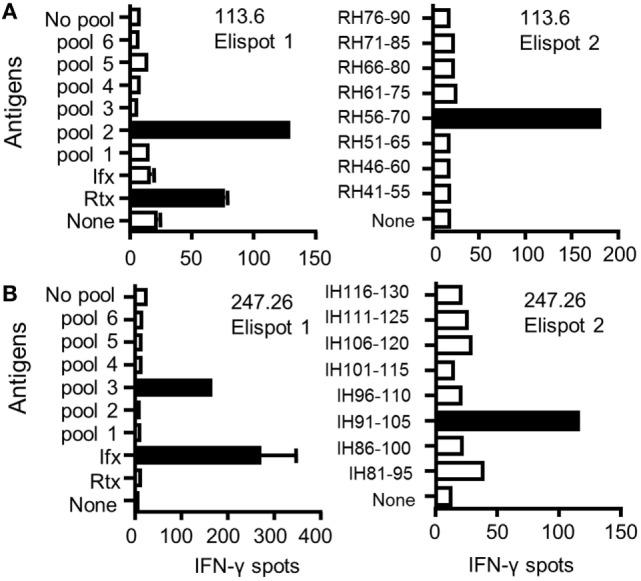
Identification of CD4 T cell epitopes of infliximab (Ifx) and rituximab (Rtx) from healthy donors. CD4 T cell lines were generated in vitro by four weekly rounds of stimulation with autologous dendritic cells (DCs) loaded with either Rtx or Ifx. Specificity of CD4 T cell lines #113.6 raised against Rtx (A) and #247.26 raised against Ifx (B) was analyzed by interferon-γ ELISPOT. T cells were incubated with autologous DCs alone (none) or with DCs previously loaded with each antibody (3 µM) or with autologous unloaded peripheral blood mononuclear cells (PBMCs) (no pool) or PBMCs loaded with a pool of peptides (10 µg/mL) (left panels) and with individual peptides (right panels).